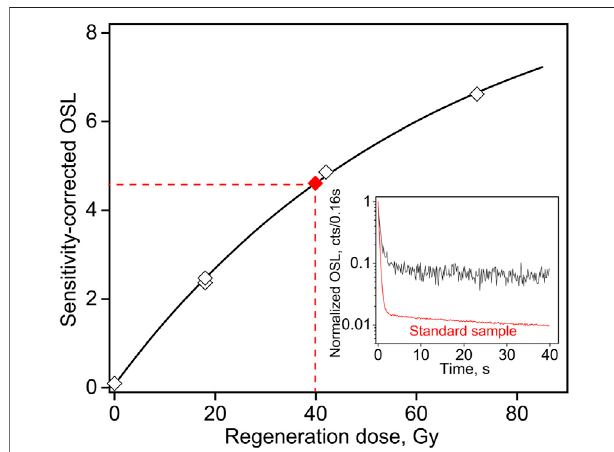
FIGURE5| Dose-responsecurveforaquartzaliquotofsampleMJOSL- 13A. The regenerated sensitivity-corrected and the natural OSL signals are displayed as open and red solid diamonds, respectively. The regeneration data are fi tted using a saturation exponential function. Inset shows a natural OSL decay curve for the aliquot, and a decay curve for a standard calibrated quartz sample from Risø is presented for comparison.